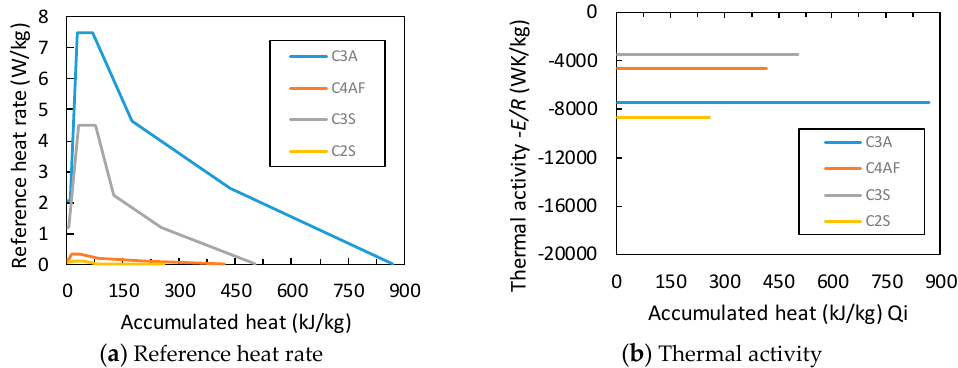
Figure 9. Modified settings of the reference heat rate and thermal activity.